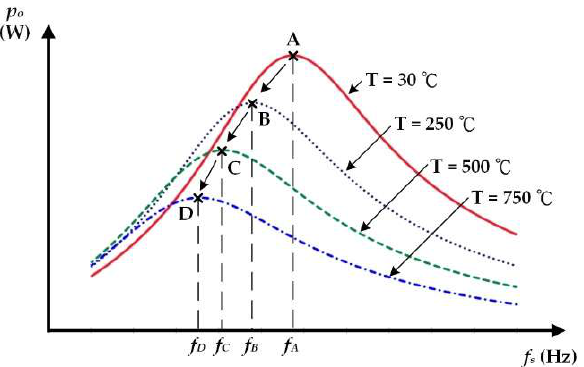
Figure 14. Frequency−power curve trend of the proposed system with temperature change.